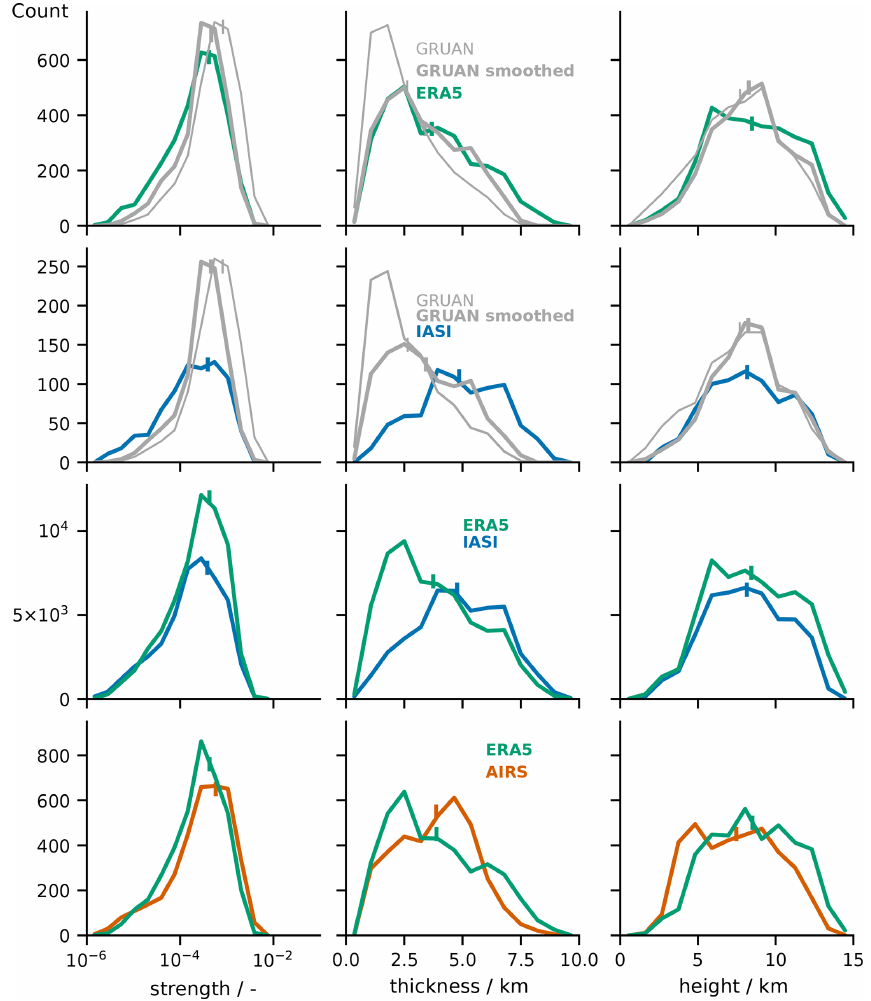
Figure 4. Distributions of moist layer characteristics (columns) for the four collocation datasets (rows). Moist layer characteristics are defined by Prange et al. (2021). The thin grey lines refer GRUAN profiles on 10m vertical resolution, while the thick grey lines represent GRUAN profiles with an applied running mean with a 1km evenly weighed vertical